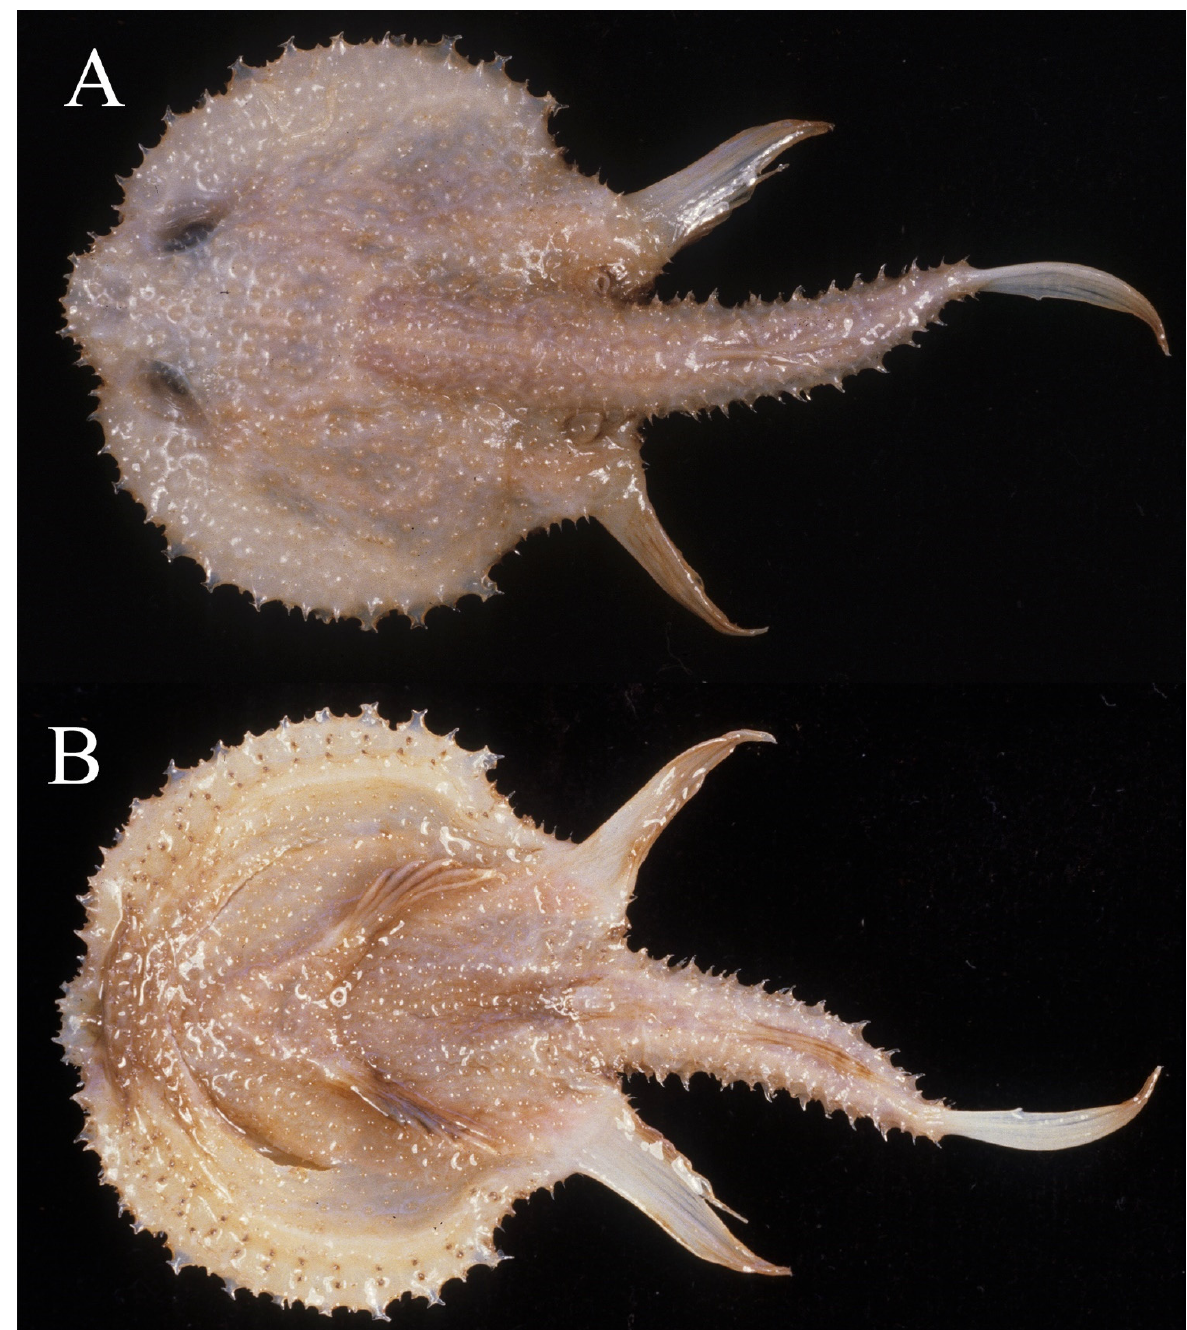
Figure 9. Halieutopsis galatea Bradbury, 1988, holotype, ZMUC 922207, 55.1 mm SL, Western Indian Ocean, photos by M. G. Bradbury. ( A ). Dorsal view. ( B ). Ventral view. Non-types. Madagascar: MNHN 1986-0018 (1, 89.0), n.o.vauban, sta. ch103, 22°18 ′ S, 43°0 ′ 3.6 ″ E, 880 ‒ 920 m, 29 November 1973. Western Australia: NMV A29727-006 (2, 26.2 ‒ 41.9), 13°15 ′ 32.4 ″ S, 123°22 ′ 33.6 ″ E, North West Shelf, 404 ‒ 405 mm 6 July 2007; WAM P.25400.003 (1, 39.6), Browse Island, 13°28 ′ S, 123°09 ′ E, 370 m, 23 December 1969. West- ern Indian Ocean : ZMMU P15825 (1, 70.4), 8°00 ′ 04 ″ S, 59°15 ′ 08 ″ E, 1220 m, 10 November 1976 (Figure 10).